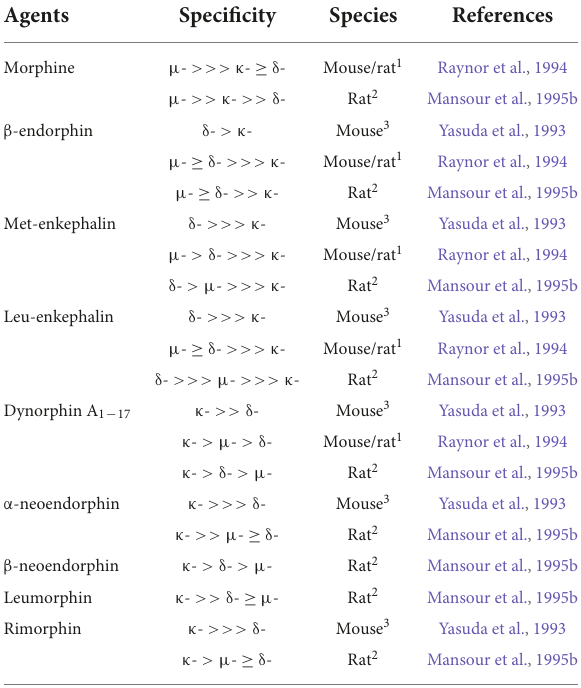
TABLE 2 Binding affinity and specificity of morphine and endogenous opioid peptides to opioid receptors. Agents Specificity Species